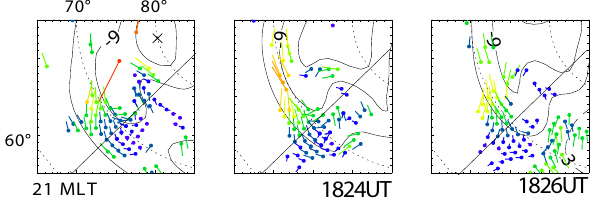
Fig. 7. SuperDARN map potential plots at two-minute intervals with the true vectors superposed at 18:22, 18:24 and 18:26 UT on 1 September 2002.